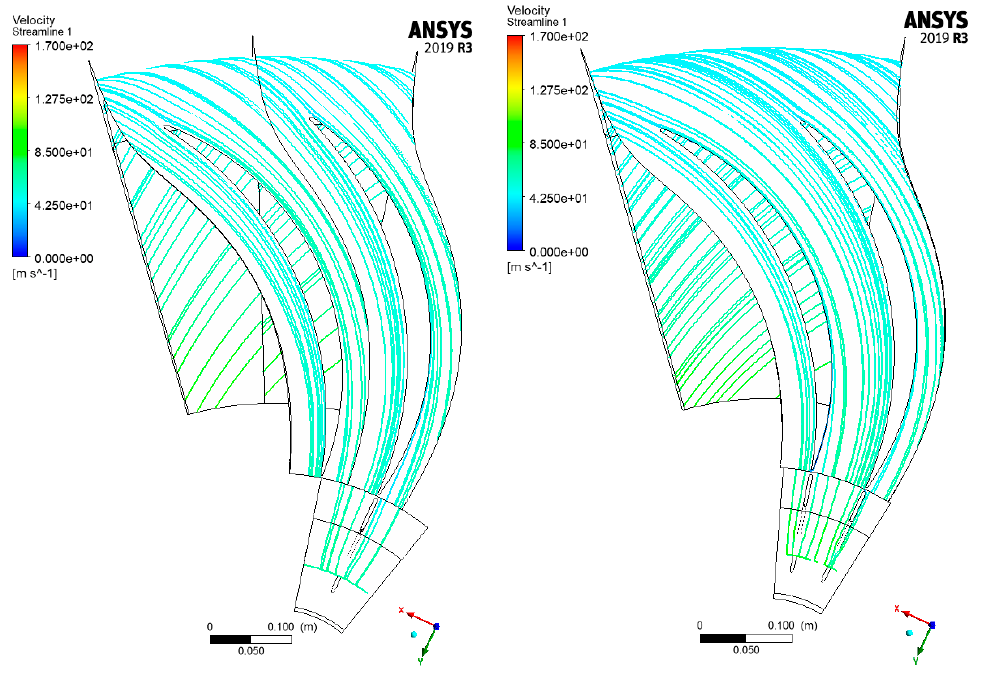
Figure 9. The flow in the return channel with different numbers of splitter vanes. Left: standard solution with splitter vanes after each second vane. Right: splitter vanes after each vane. Velocity legend: from 0 to 170 m/s.